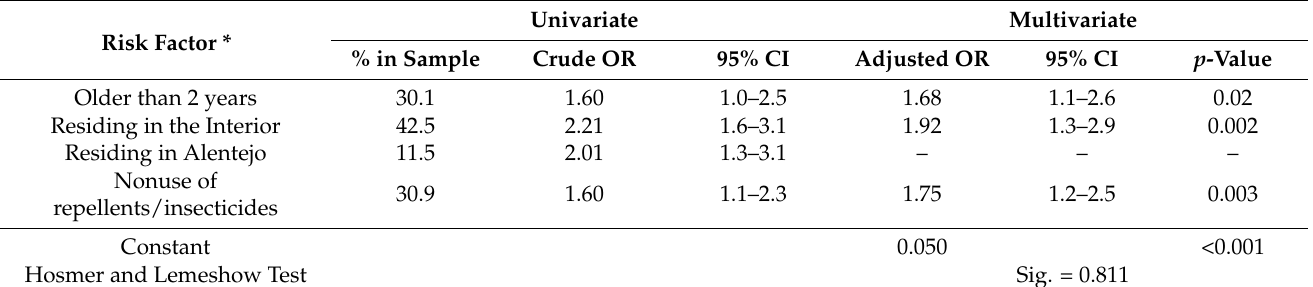
Table 3. Potential risk factors for Leishmania infection excluding vaccinated dogs, according to logistic regression models to estimate crude and adjusted odds ratio